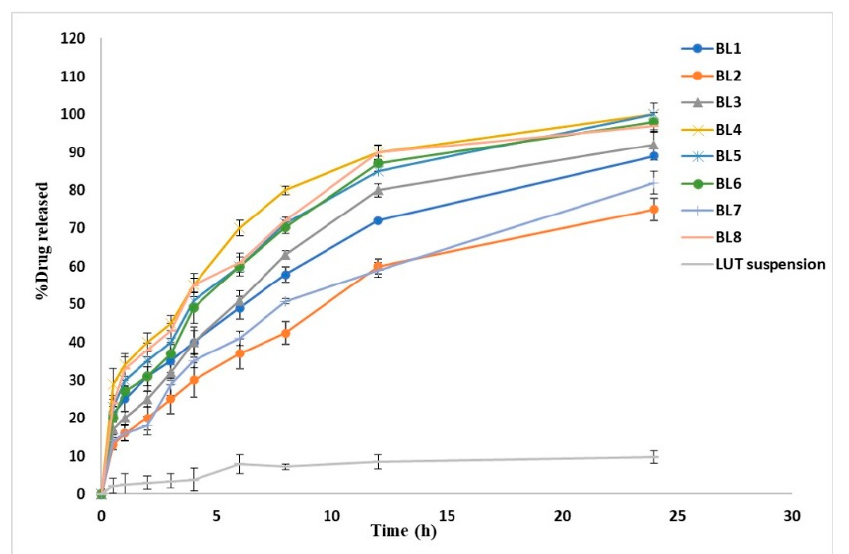
Figure 5. In vitro release profile of luteolin in phosphate buffer (pH 6.8) from LUT suspension and different LUT-loaded BLs. Results are represented as mean ± SD, n = 3.